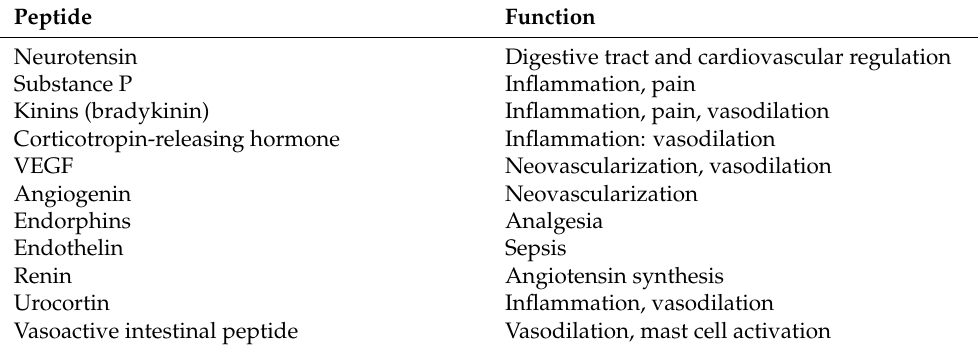
Table 3. Some peptides released by